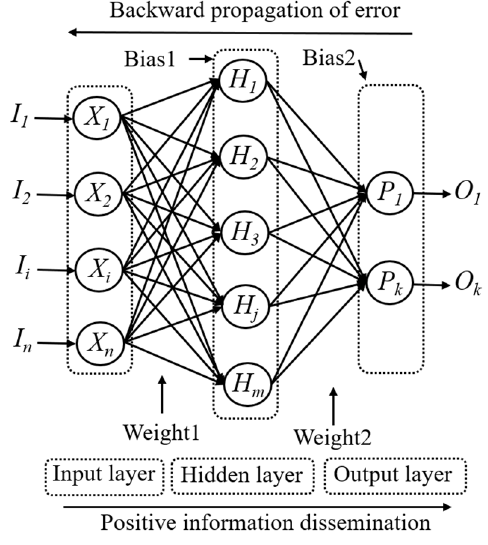
Figure 12. The structure of multi-layer back-propagation neural networks.